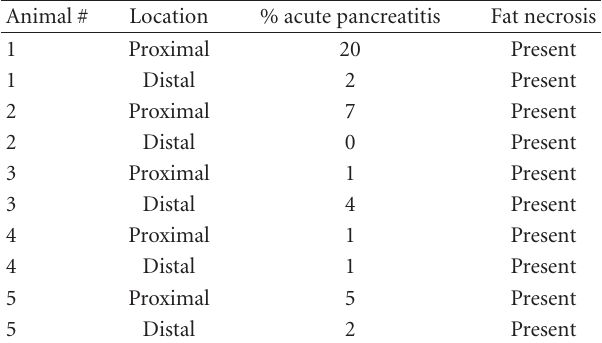
Table 1: Scoring of histologic